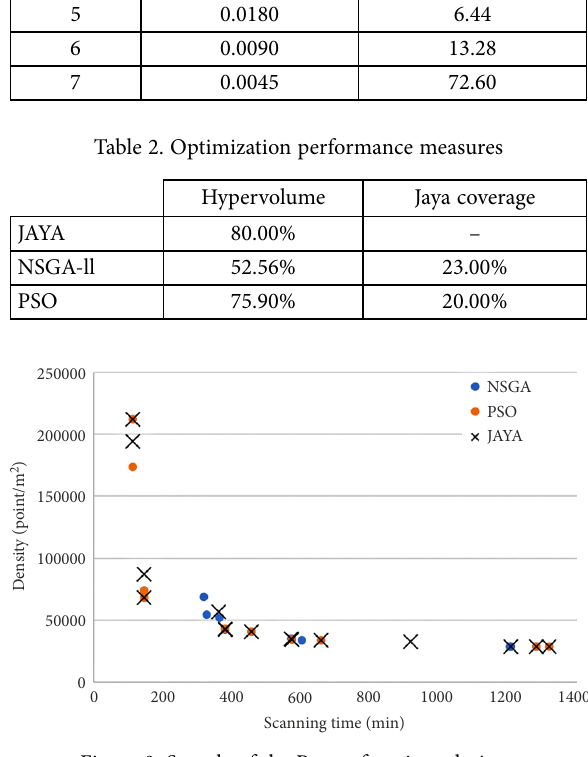
cloudFigure 9. Sample of the Pareto frontier solutions for the